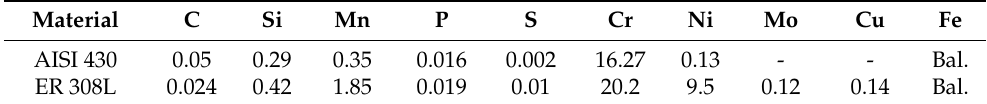
Table 1. Chemical constituents of the base metal and filler metal (wt.%).